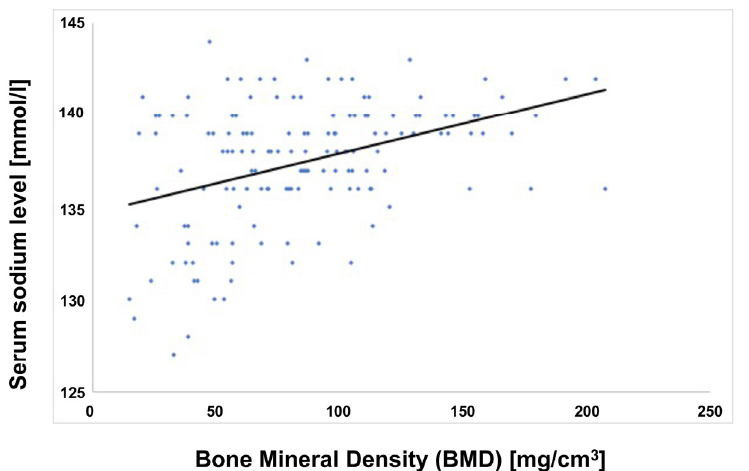
Figure 3. Correlation between bone mineral density (BMD) and serum sodium level. A positive correlation between BMD and serum sodium level (r = 0.396; p* ** < 0.001)) in the low-energy group (n = 144) is shown. The serum sodium levels [mmol/L] are indicated on the y-axis and the bone mineral density [mg/cm 3 ] is presented on the x-axis.